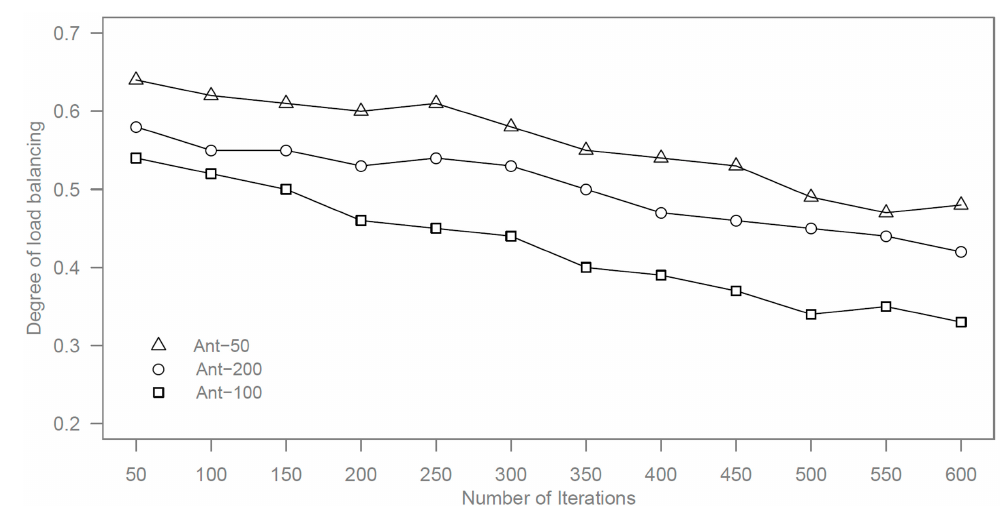
Figure 3. Degree of load balancing by different numbers of